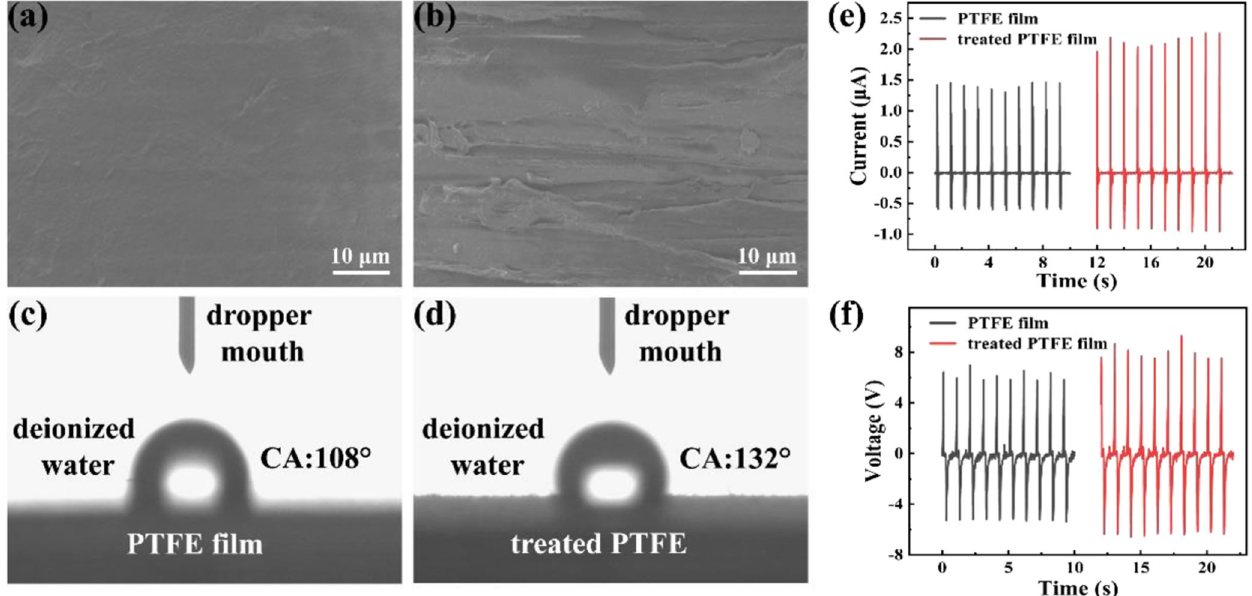
Fig. 2 The performance of PTFE fi lm after surface treatment. SEM image of the PTFE fi lm before ( a ) and after ( b ) being polished with emery papers. The hydrophobicity images of deionized water drop on a PTFE fi lm before ( c ) and after ( d ) being polished with emery papers. Short- circuit current ( e ) and open-circuit voltage ( f ) between the two dielectric materials of PTFE fi lm and Al